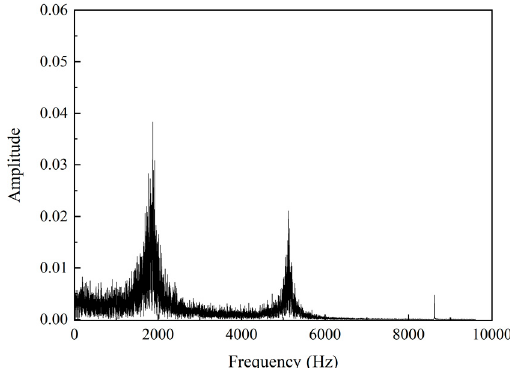
Figure 9. Typical frequency spectrum distribution of the impact pressure. Experimental conditions: P in = 15.5 MPa and L c / D = 8.